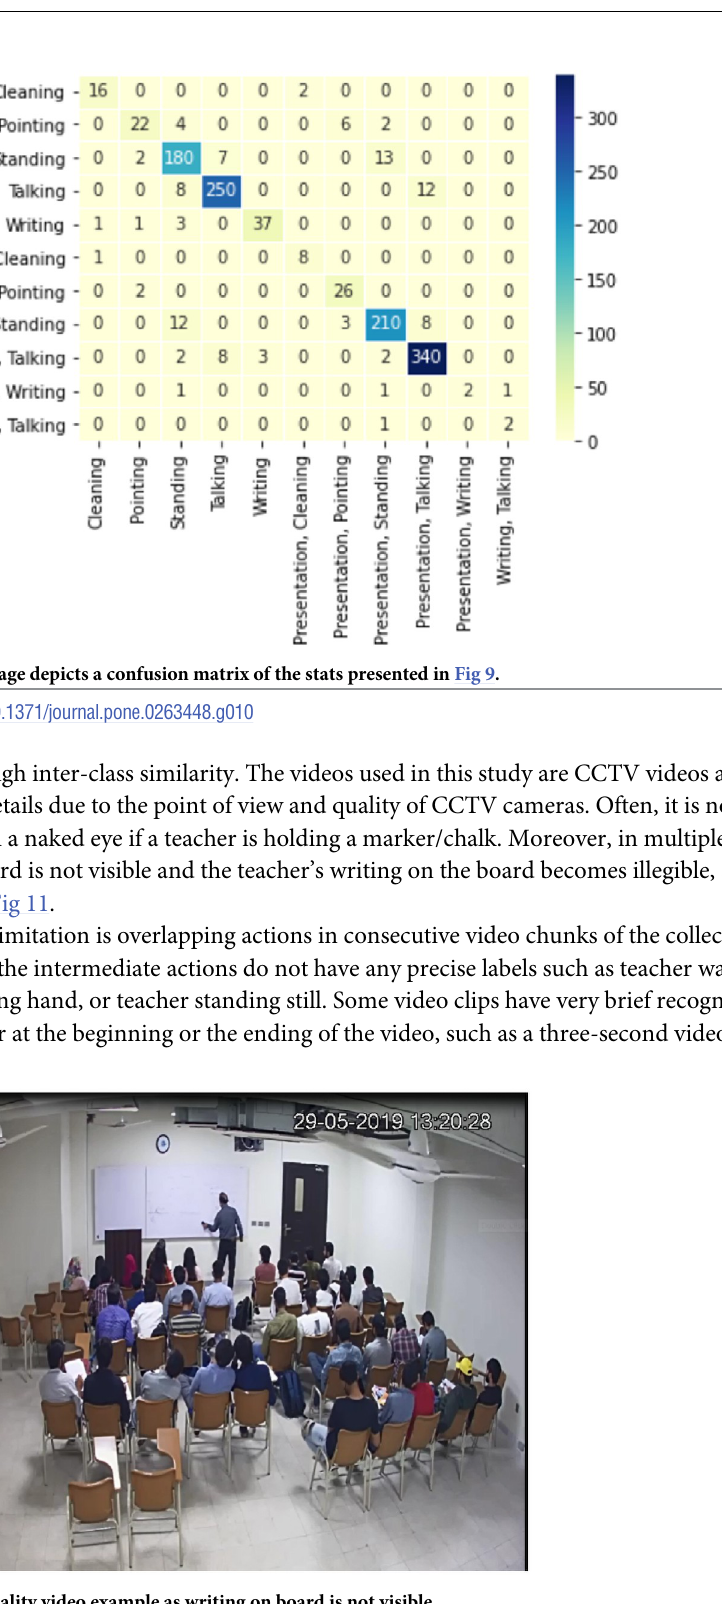
Fig 11. Poor quality video example as writing on board is not